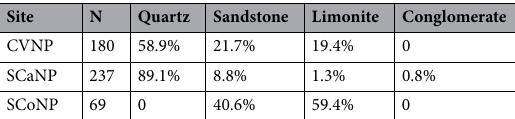
Table 2. Stone tools characteristics in each site.